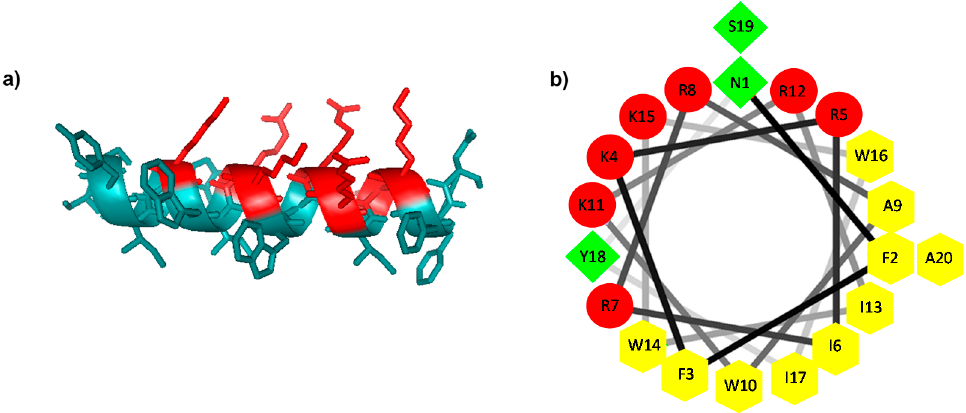
Figure 1. Predicted structure of the ∆ M4 peptide. ( a ) Predicted α -helical structure of the ∆ M4 peptide; positively charged residues are highlighted in red. ( b ) Helical-wheel projection of ∆ M4; basic residues are presented as pentagons, non-polar residues as green squares, and polar uncharged residues as circles.